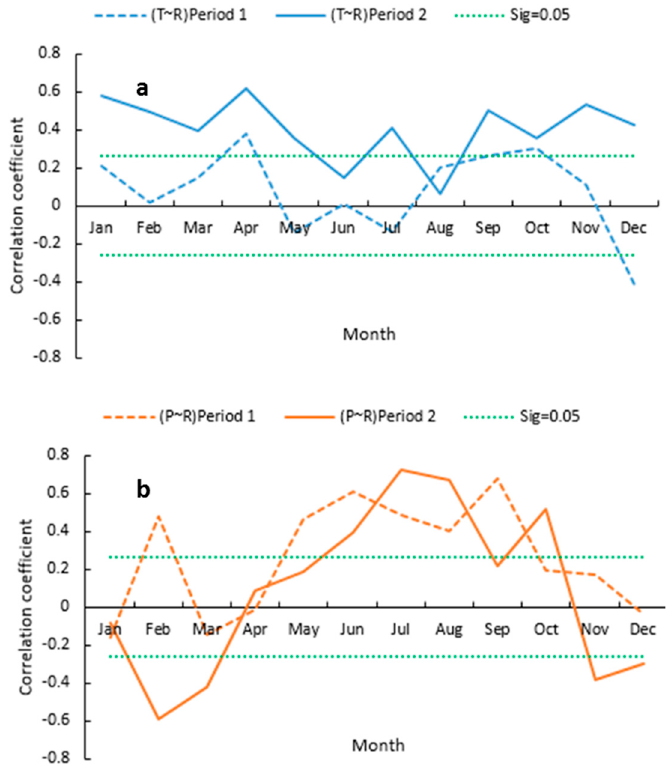
Figure 7. Correlation between monthly precipitation and runoff and temperature and runoff; ( a ) 1957–1990 (period 1); ( b ) 1991–2013 (period 2); significance level 0.05 is shown as a green dot line, positive correlation above and negative correlation below green line are statistically significant.